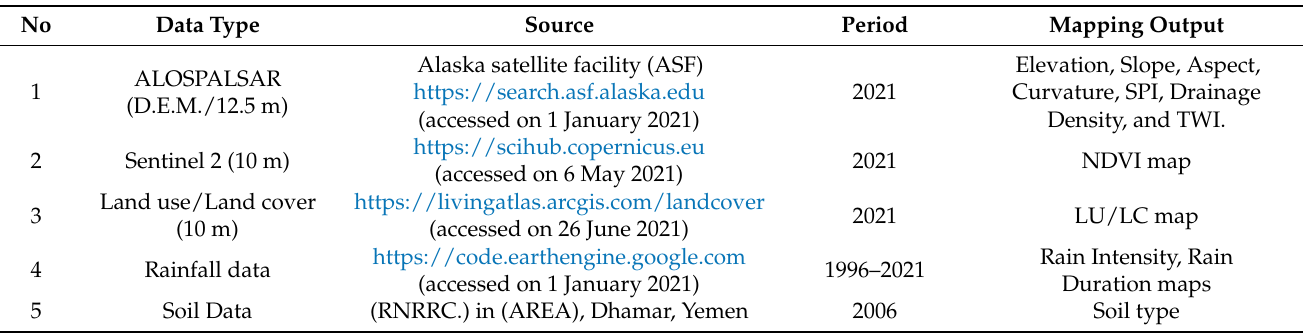
Table 2. Lists the sources of data types used in this